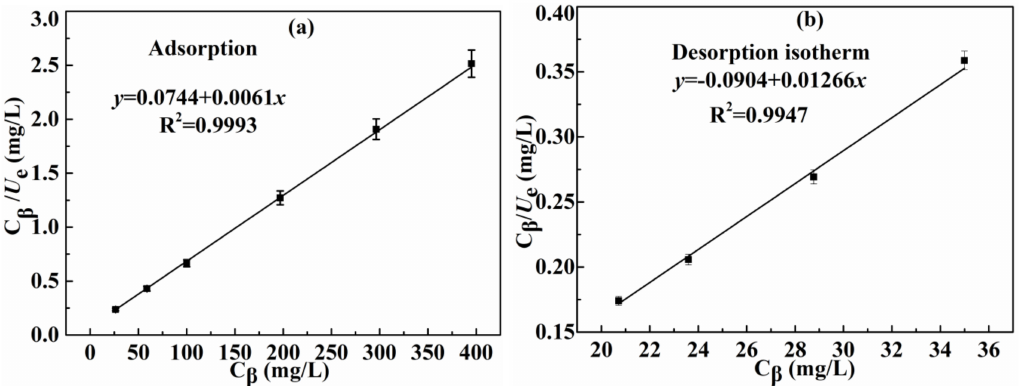
Figure 9. Linear Langmuir plot of adsorption ( a ) and desorption of BA-PGMA ( b